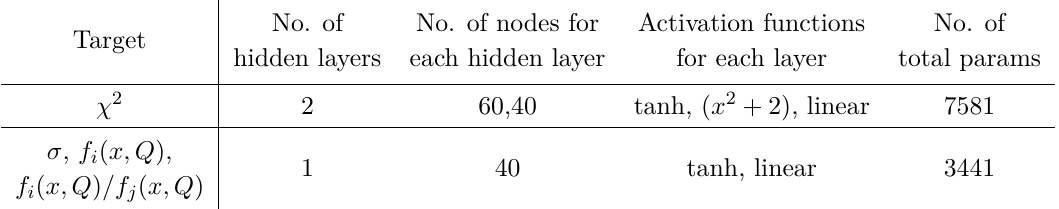
Table 1 . The architecture of NNs in this paper. Structure is set up for either χ 2 or other